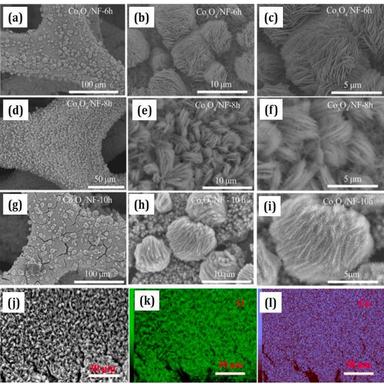
SEM images: (a–c) Co3O4-Ni foam for 6 hrs; (d–f) Co3O4-NF for 8 hrs; (g–i) Co3O4-NF for 10 hrs; (j–l) element mapping images of Co3O4 nanoflakes. Reproduced from Ref. ..